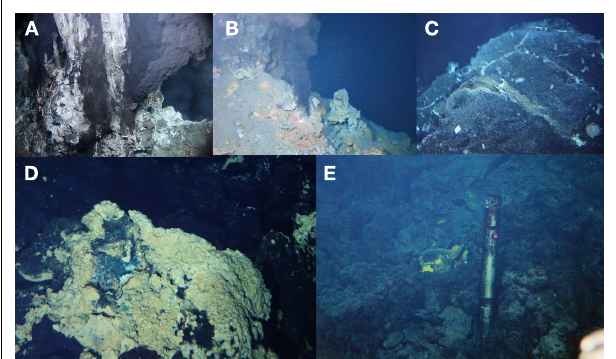
FIGURE 1 | On-site observation of the seafloor in the SMT. Photos were taken by Shinkai 6500 (JAMSTEC, Japan) in 2010. (A) A black smoker chimney at the Archaean site, (B) a black smoker chimney at the Pika site, (C) diffuse flows from crack of pillow lavas at the Snail site, (D) iron-rich mats at the Snail site, and (E) a casing pipe inserted into a borehole at the Snail